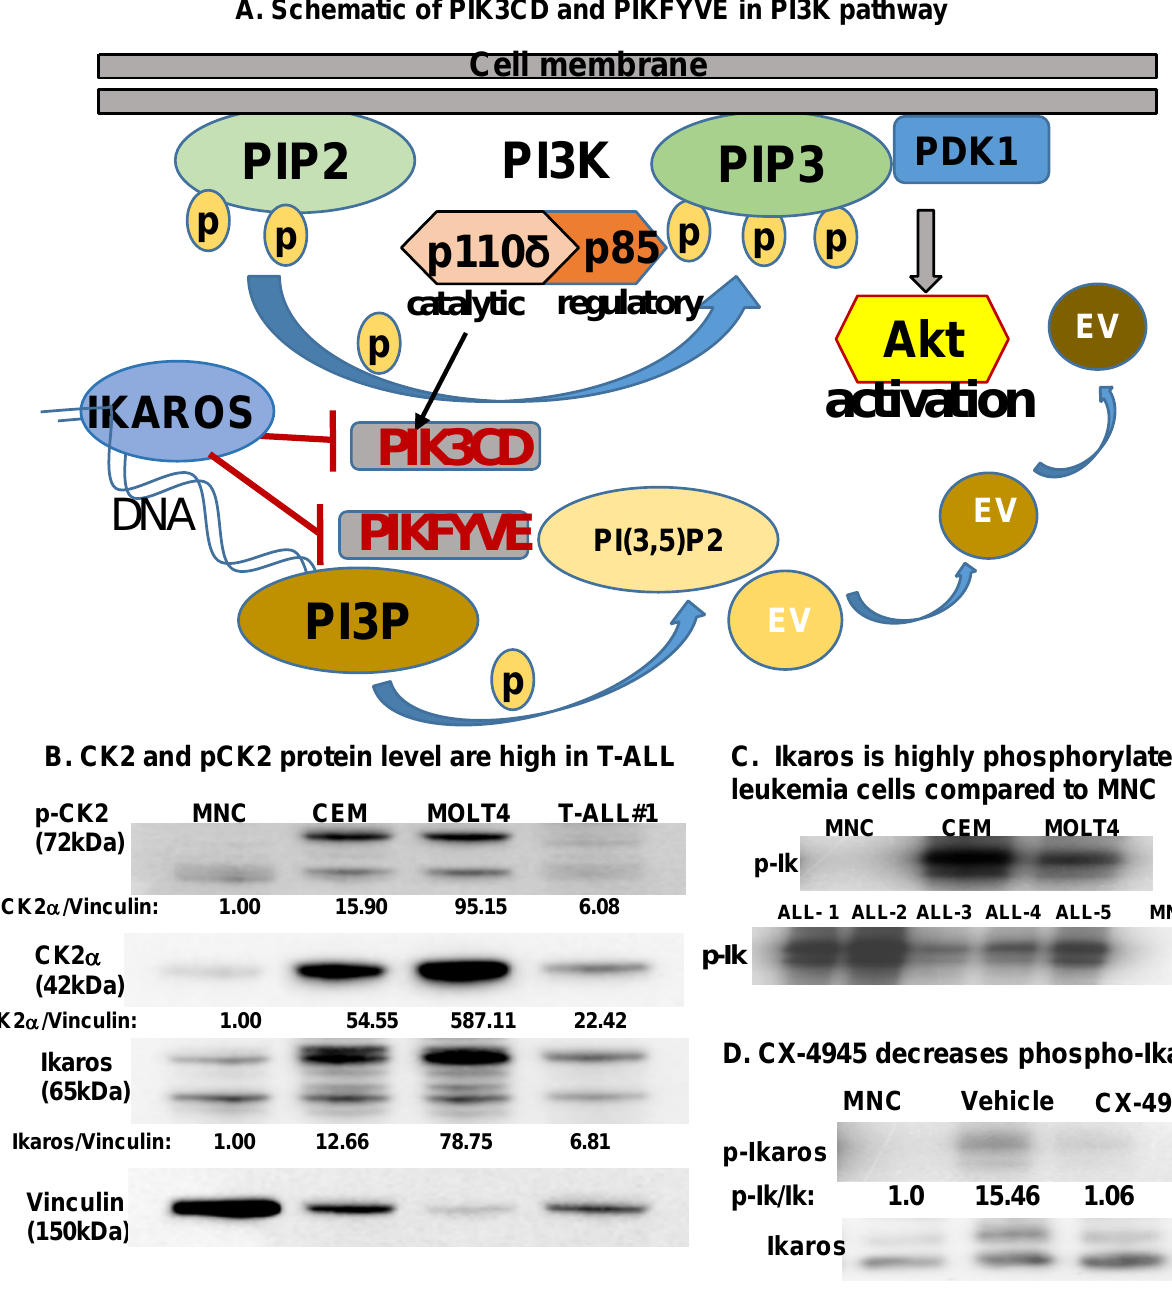
Figure 1. CK2 is overexpressed in T-ALL compared to normal mononuclear cells . ( A ) Schematic showing PIK3CD and PIKFYVE genes in the PI3K pathway. ( B ) Baseline protein levels of CK2 α , pCK2, and IKAROS in the T cell leukemia cell panel (CCRF-CEM, MOLT4, and primary T-ALL cells (labeled T-ALL#1)) were measured by Western blot and compared to peripheral blood mononuclear cells (MNCs). The protein level is graphed relative to vinculin as a loading control. ( C ) Radio- immunoblot showing phospho-IKAROS in a leukemia cell panel (CCRF-CEM, MOLT4, and primary T-ALL cells (labeled ALL#1-5)) compared to MNCs. ( D ) Radio-immunoblot showing a decrease in the phospho-IKAROS level following CX-4945 treatment. MOLT4 cells were treated with 10 µ M of CX-4945 for 24 h. EV, endosomal vesicle; PIK3CD, phosphatidylinositol 4,5-bisphosphate 3-kinase catalytic subunit delta; and PIKFYVE, phosphoinositide kinase, FYVE-type zinc finger containing; PI3K, phosphoinositide 3-kinase; P, phospho; PIP2, phosphatidylinositol 4,5-bisphosphate; PIP3, phosphatidylinositol 3,4,5- trisphosphate; PDK1, phosphoinositide-dependent kinase; PI3P, phosphatidylinositol-3-phosphate; PI(3,5)P2, phosphotydile inositol